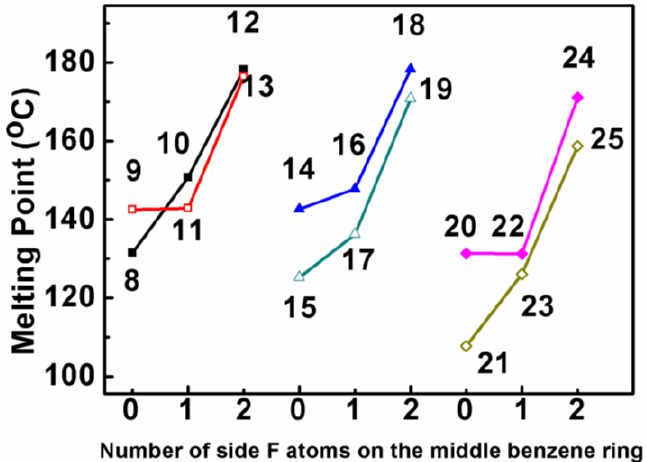
Figure 1. Effect of side-substituted fluorine atoms and end groups on melting